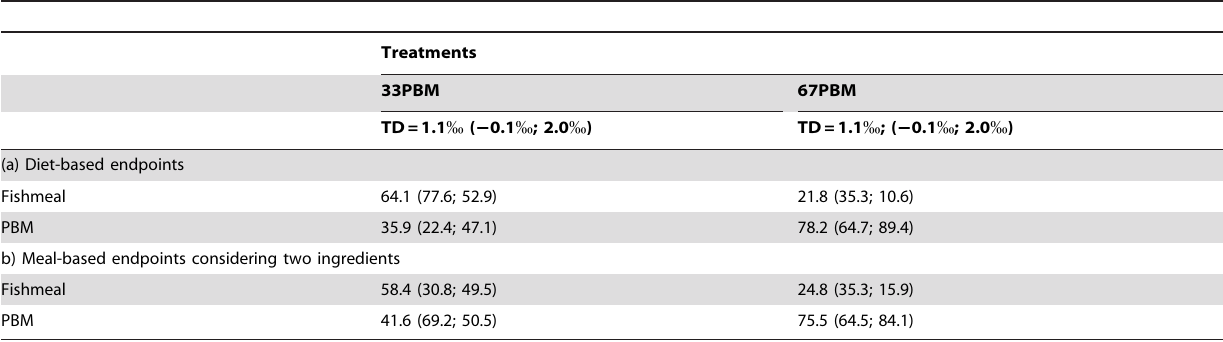
Table 3. Percentage of nitrogen retention by rainbow trout ( Oncorhynchus mykiss ) fed formulated diets with two levels (33 and 67%) replacement of fishmeal (FM) with poultry by-product meal